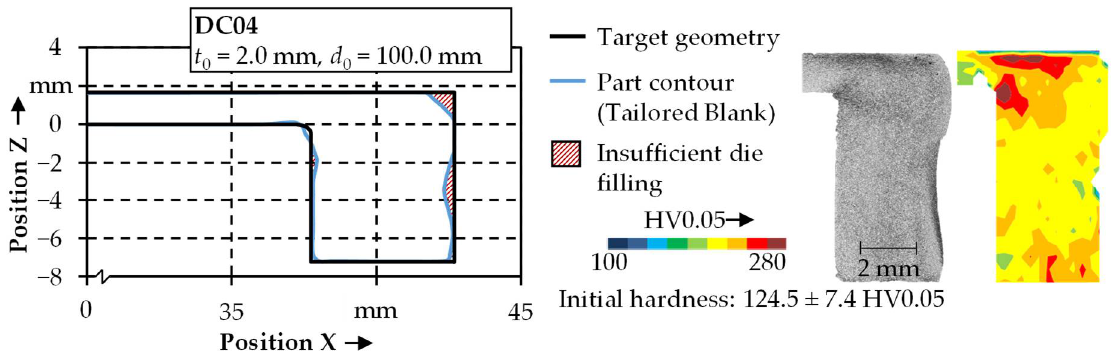
Figure 10. Experimental results obtained with the investigated tailored blank layout.